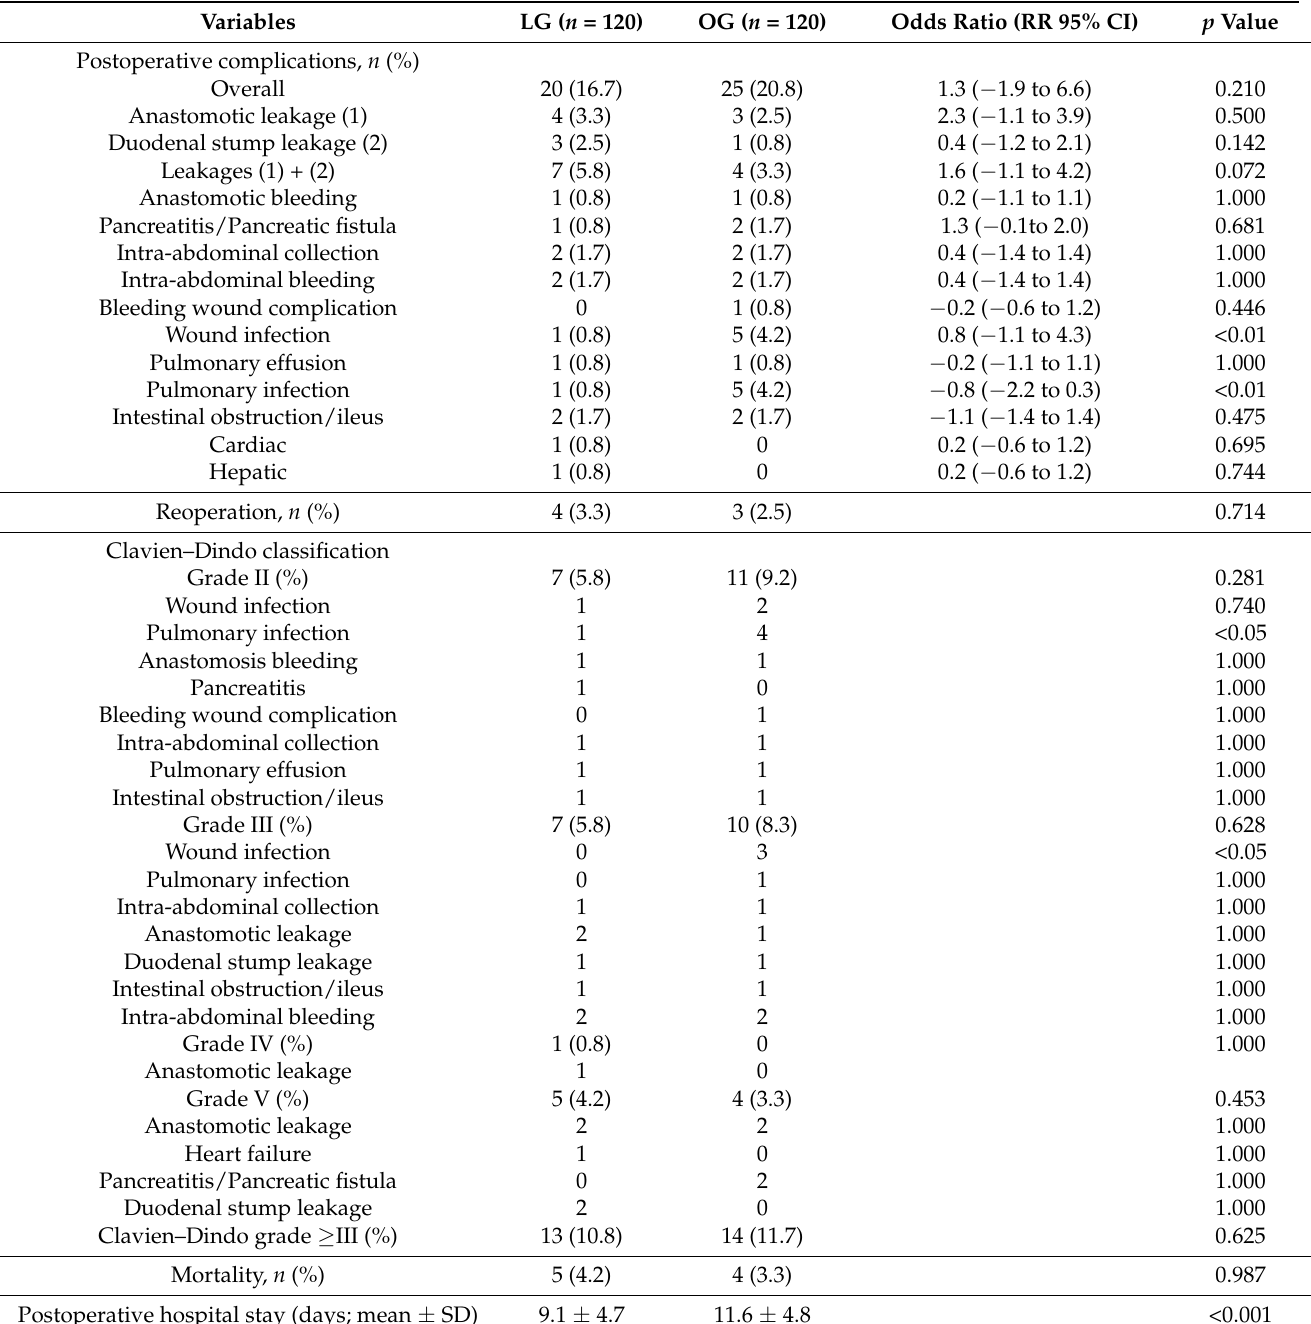
Table 3. Adverse